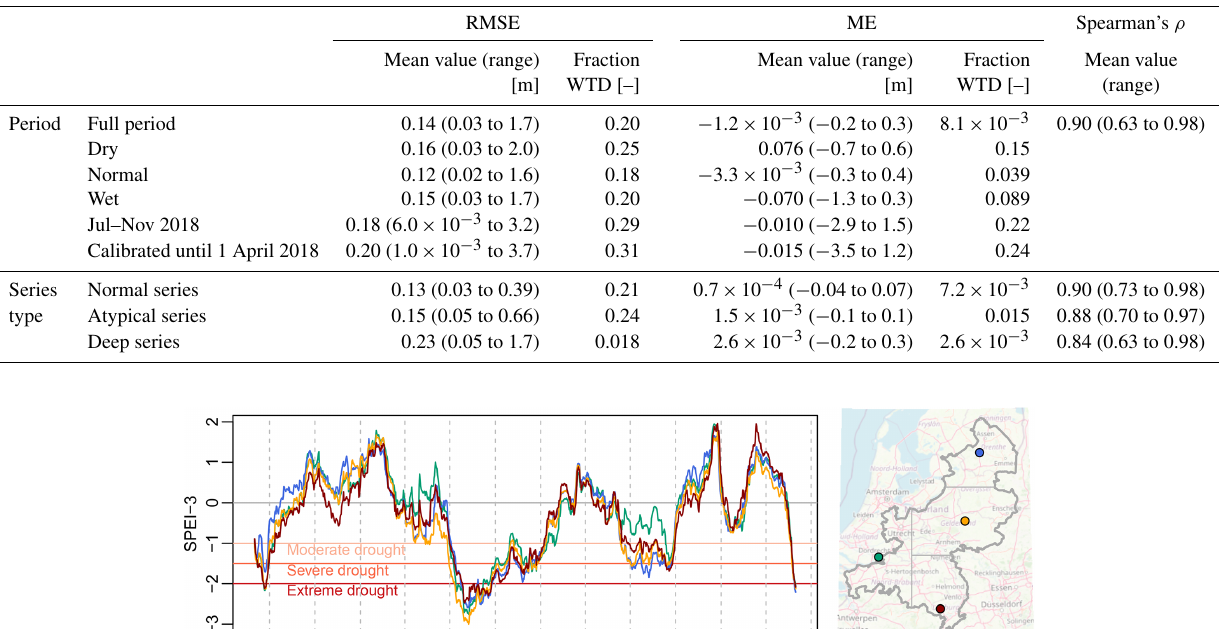
Table 5. Performance of the groundwater head simulations for several subperiods and the three series types (Sect. 3.2). RMSE represents root-mean-square error, and ME is the mean error of simulations vs. measurements, given in metres and as fraction of the mean groundwater table depth (WTD).